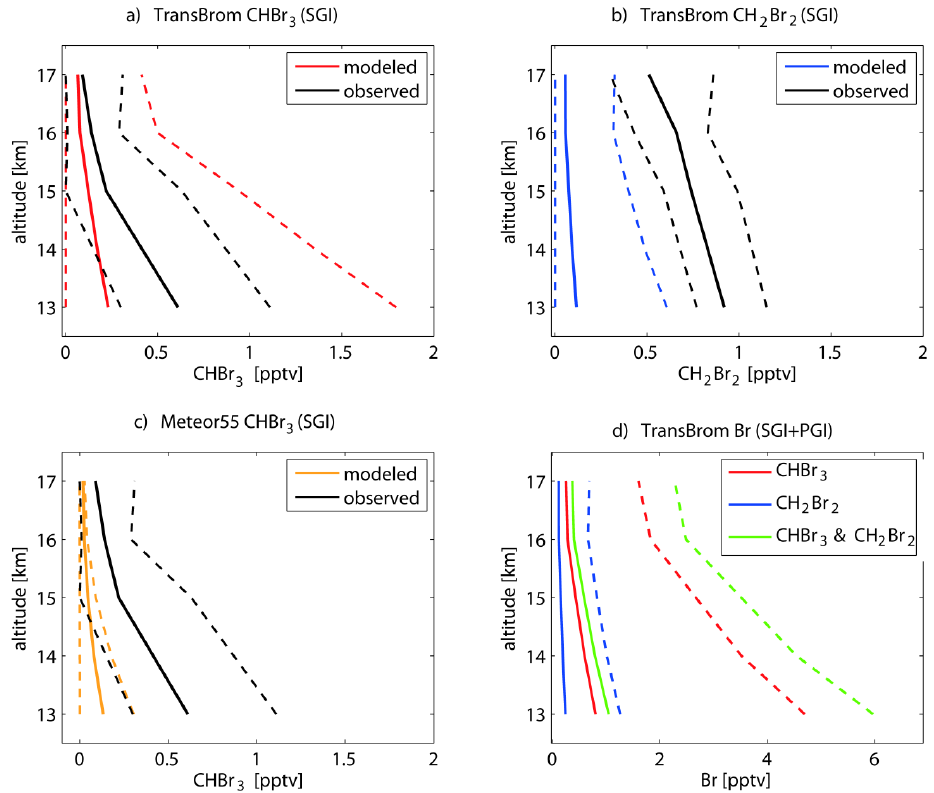
Fig. 5. VSLS profiles based on atmospheric observations (black lines) and estimated from observed emissions (colored lines) of West Pacific CHBr 3 (a) , West Pacific CH 2 Br 2 (b) , and tropical Atlantic CHBr 3 (c) are shown. Also total Br profiles (PG and SG) based on West Pacific CHBr 3 and CH 2 Br 2 emissions are displayed (d) . For all profiles lower and upper limits (dashed lines) and mean values (solid lines) are